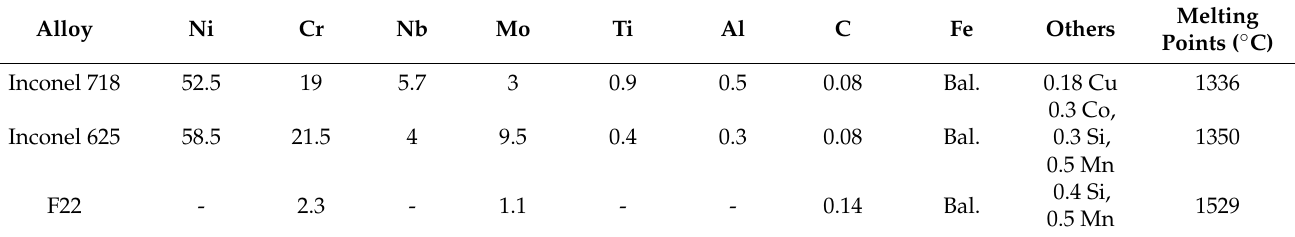
Table 1. Chemical composition (wt%) of the Inconel 718, Inconel 625, and F22.